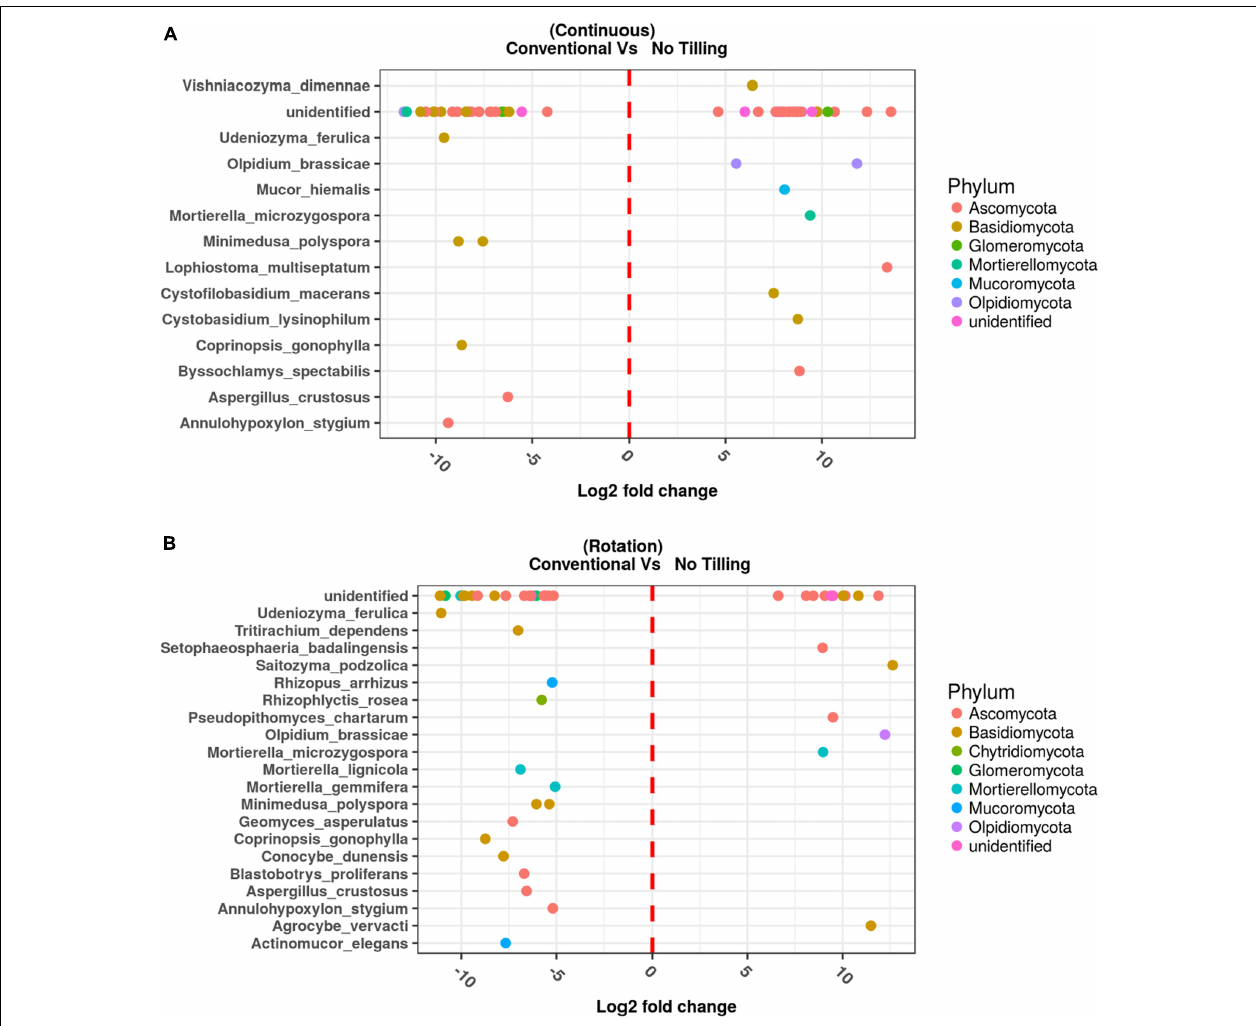
FIGURE 8 | Differentially enriched operational taxonomic units assigned at the species level, assessed by EdgeR in the comparison between Conventional Tilling (T) and No Tilling (NT) under (A) continuous cropping system (NR) and (B) Rotation (R). Differentially enriched operational taxonomic units (OTUs) assigned at the genus, or higher taxonomic level are also reported in Supplementary Table 5